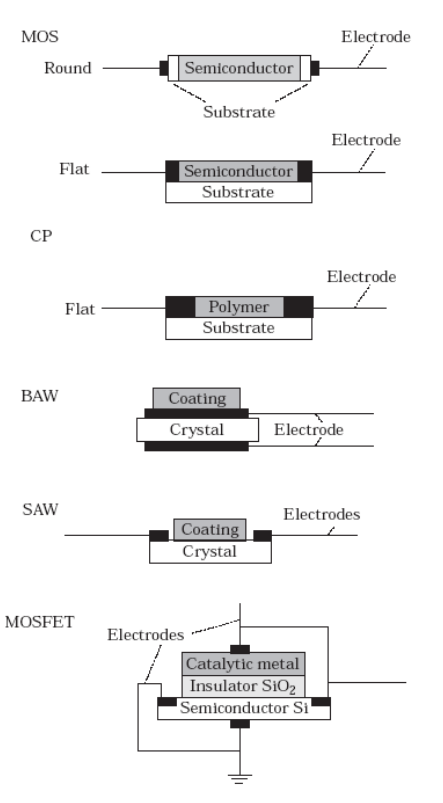
Figure 2. Schematic diagrams of 5 different kinds of sensors. Caption: MOS = Metal oxide semiconductor; CP = Conducting polymer; BAW = Bulk acoustic wave; SAW = Surface acoustic wave; MOSFET = Metal oxide semiconductor field effect